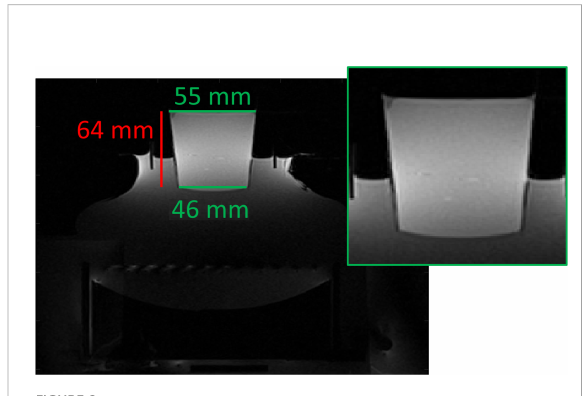
FIGURE 2 Illustration of TMM gel phantom placed on top of the MRgHIFU transducer system. This MR image is a transverse view generated from a T1-VIBE sequence. The inset shows an enlarged view of the TMM phantom. Also visible in the image is the transducer and coupling